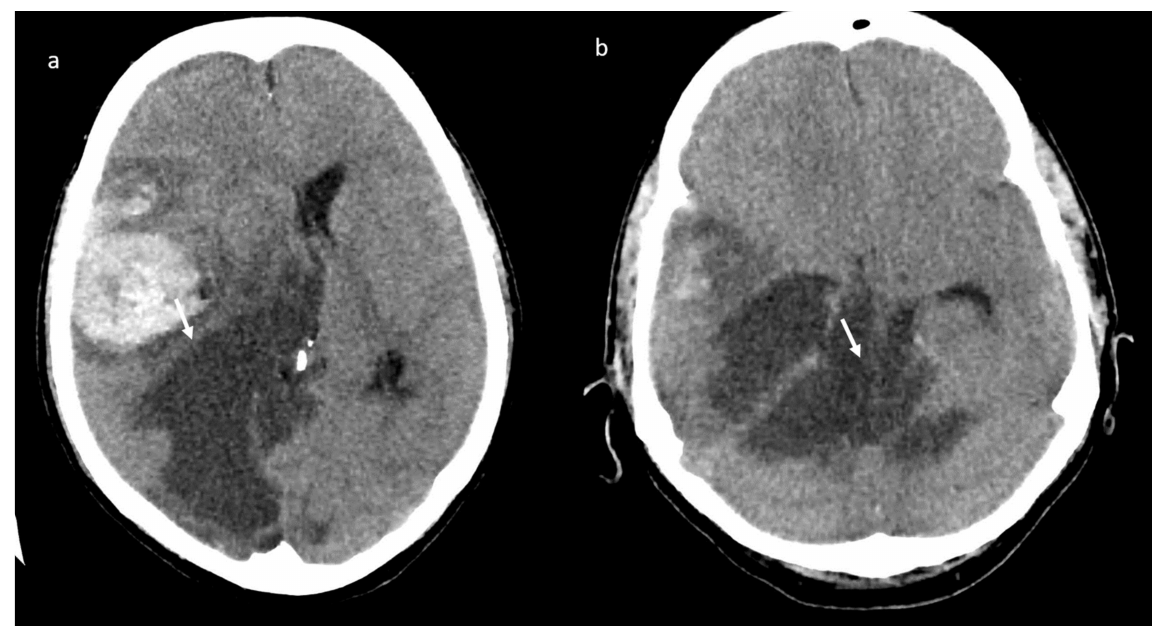
Figure 9. Brain CT scan: diffuse ischemic hypodensity involving the right occipito-temporal ( a ) and the superior cerebellar regions, the right thalamic and internal capsula regions, pons and mesencephalon ( b